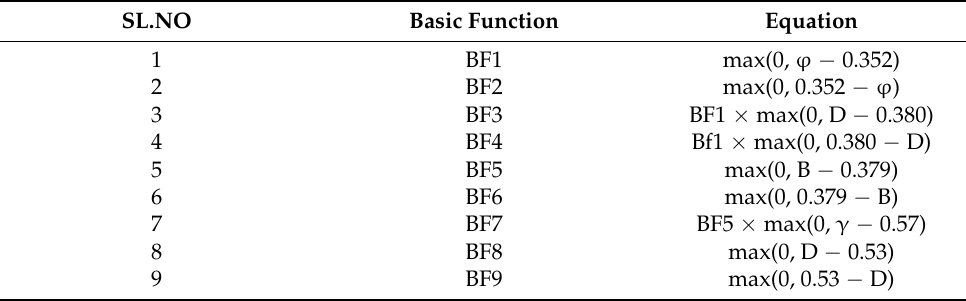
Table 3. Equation of basic functions in MARS